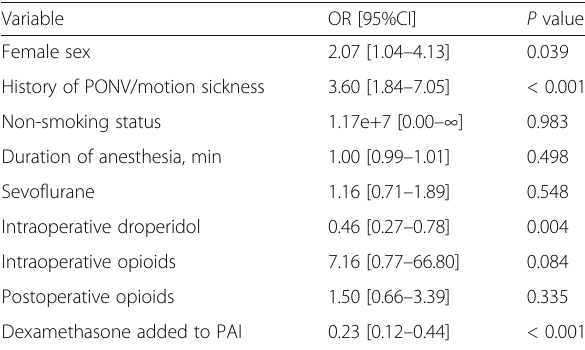
Table 2 Multivariate logistic regression analysis of patient characteristics associated with postoperative nausea and